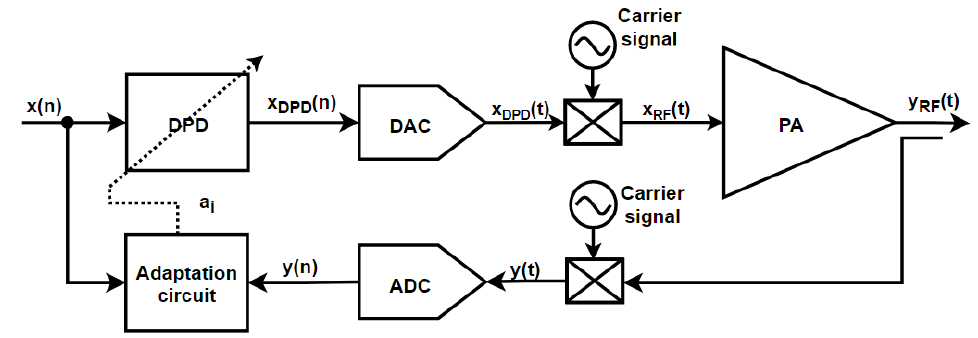
Figure 12. MRAS transmitter.